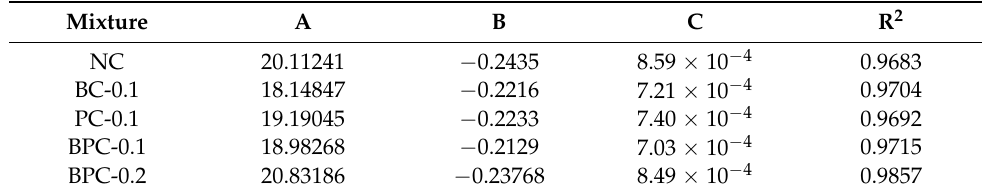
Table 5. Fitting results of material characteristic